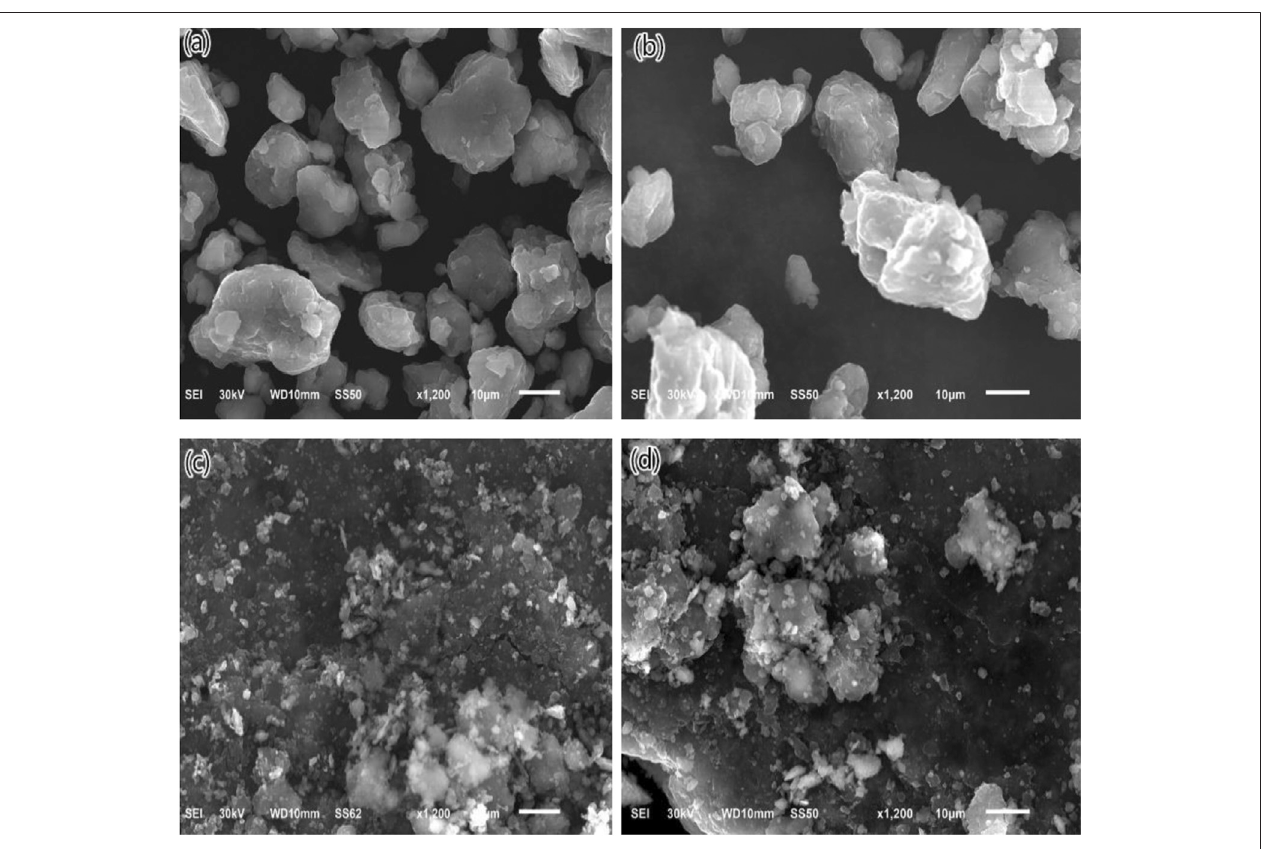
FIGURE 2 | SEM images of as-milled Mg − Li (A) , Mg − Li − MS (B) , Mg − Li − G (C) , and Mg − Li − MS − G (D) composites.